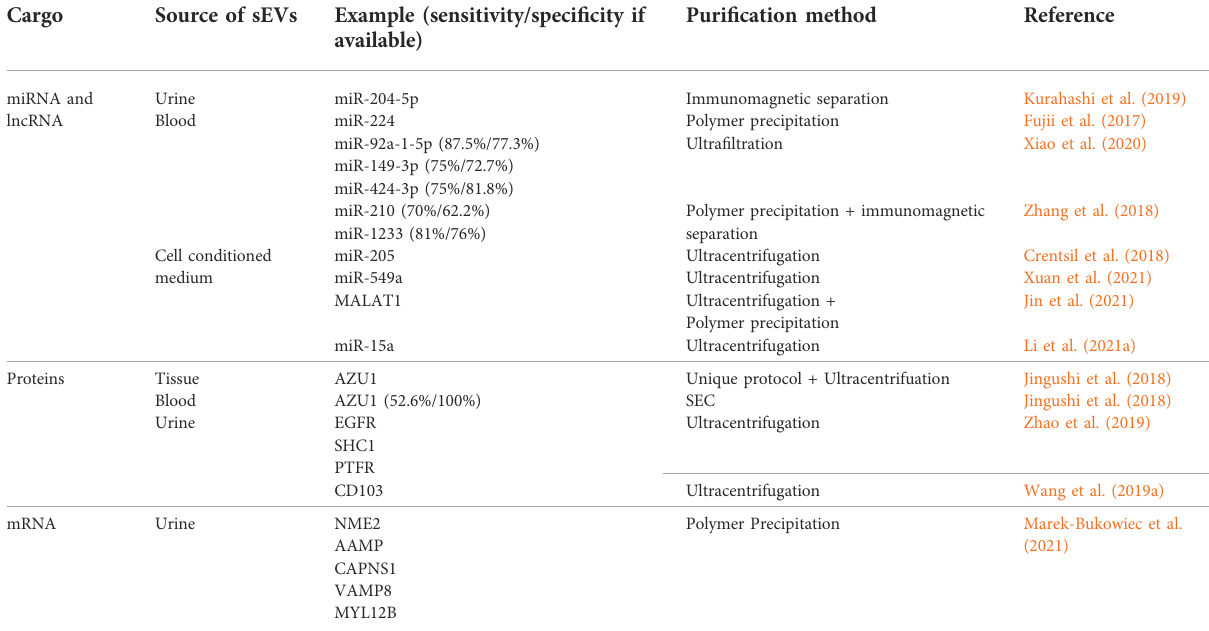
TABLE 3 Summary of the recently evaluated small extracellular vesicle cargo as potential biomarkers for renal cell carcinoma. sEVs – small extracellular vesicles, miRNA – microRNA, mRNA – messenger RNA, circRNA – circular RNA, lncRNA – long non – coding RNA, SEC – size exclusion